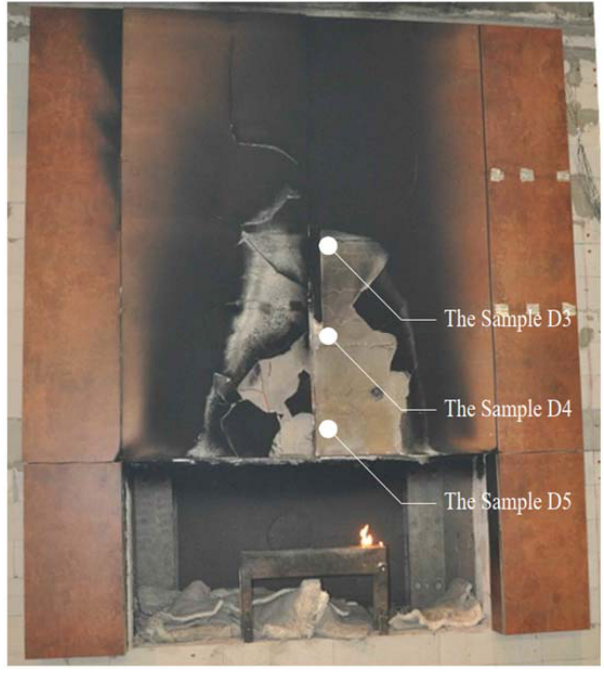
Figure 9. Sampling location. Figure 9. Sampling